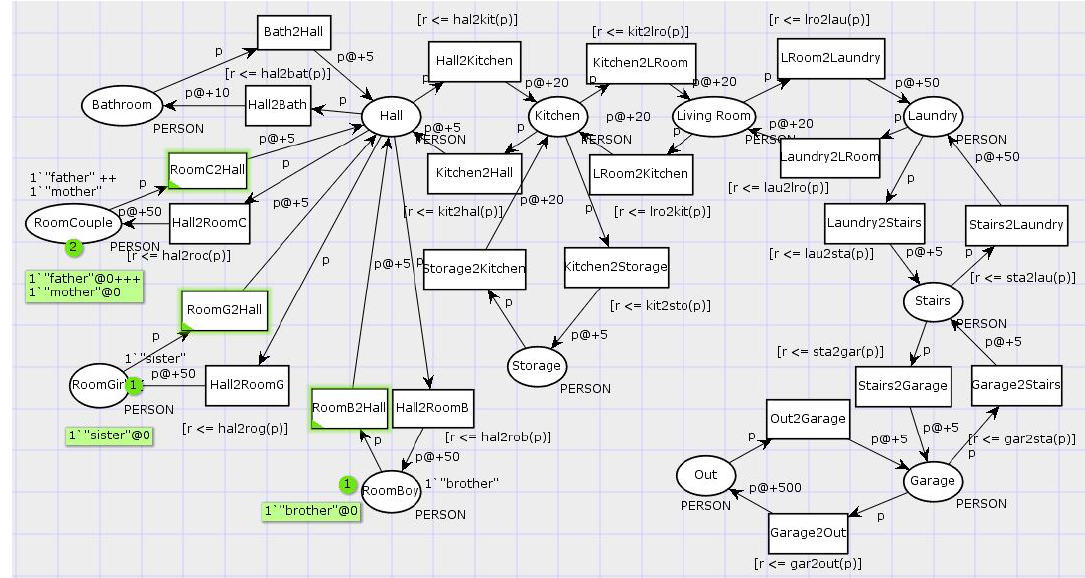
Figure 4. Executable coloured petri net model constructed in CPN Tools for smart home multi-user data